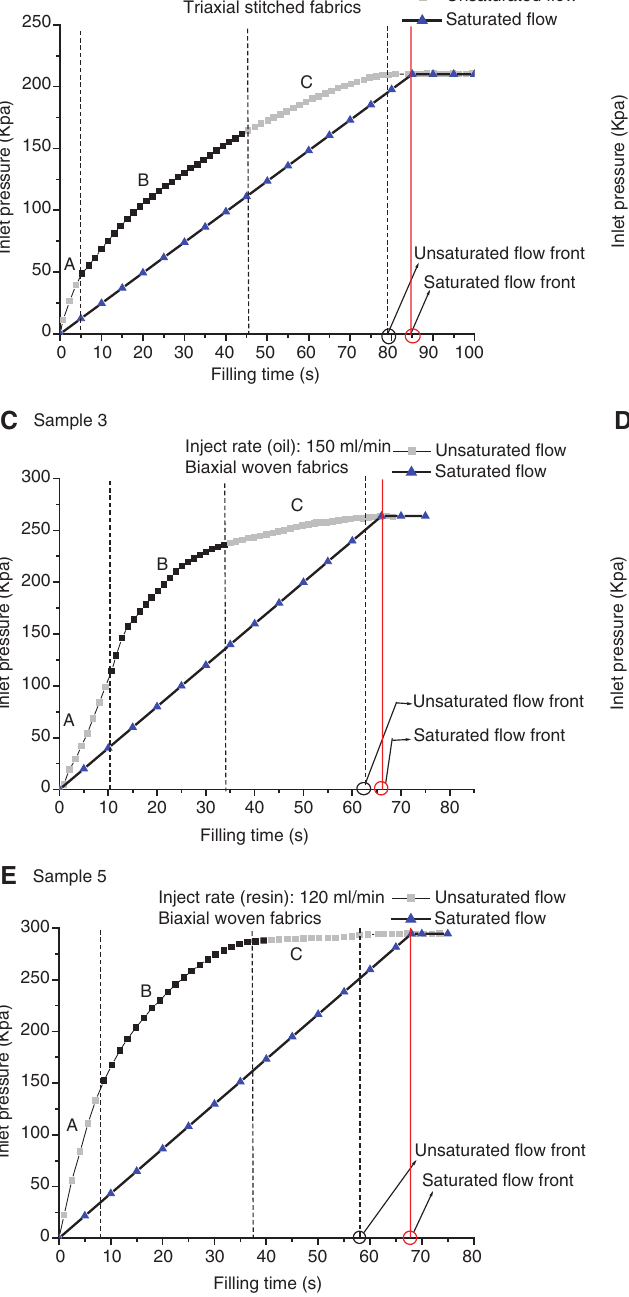
Figure 5: Plot of inlet pressure against time for different